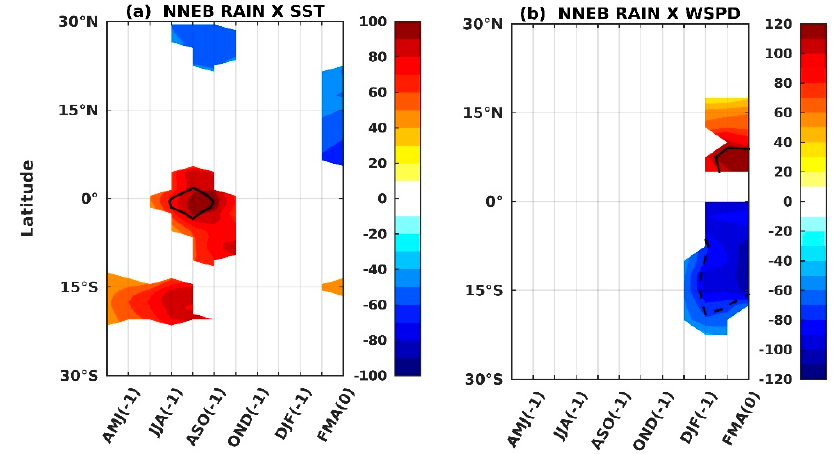
Figure 6. Latitude–time diagram of lagged linear correlation / regression between the rainfall anomalies in Northern NEB during FMA(0) and ( a ) SSTA (mm month − 1 / ◦ C) ( b ) surface wind speed anomalies (mm month − 1 / m s − 1 ) for the period 1980–2015. The SST and wind speed anomalies are averaged between 60 ◦ W–15 ◦ E. Values shown are significant at the 95% confidence level using the t -test. Contours indicate regions of correlation higher than + 0.5 (solid line) and lower than − 0.5 (dotted line) for ( a , b